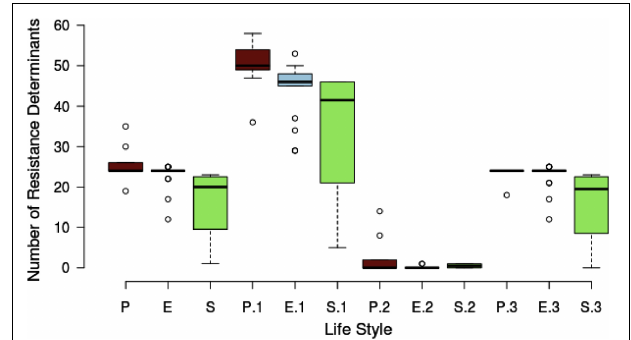
FIGURE 6 | Box plot showing the relationship between the number of resistance determinants and the lifestyle of the strains. There are 3 main lifestyle groups, nosocomial/pathogen [P (brown)], environmental/free living [E (blue)] and environmental/symbiotic [S (green)]. P, E, and S represent the total resistance determinants. P.1, E.1, and S.1 are the total efflux pump genes. P.2, E.2, and S.2 represent the acquired resistance genes and P.3, E.3, and